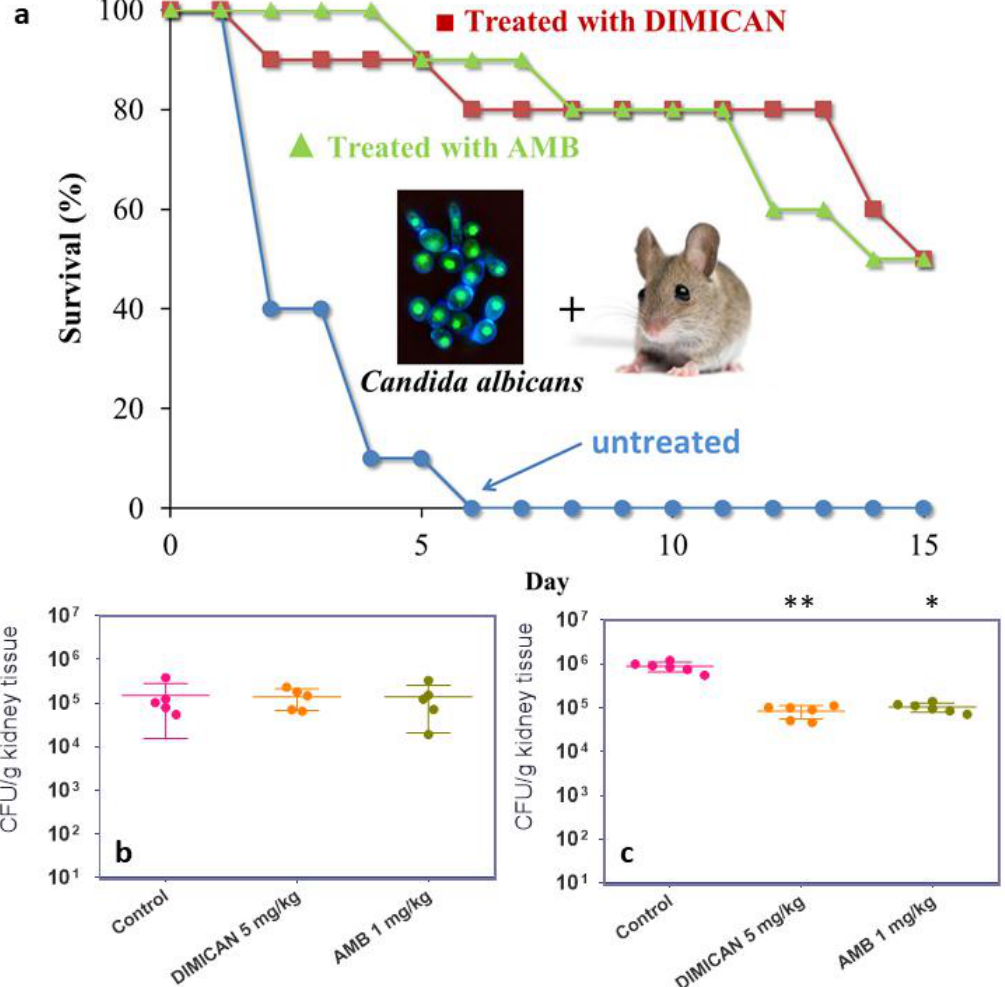
Figure 3. In vivo antifungal activity results for DIMICAN against Candida albicans 3666 isolate. ( a ) Survival curves of mice infected with Candida albicans 3666 isolate. For all groups n = 10. ( b ) Kidney tissue burden of immunosuppressed mice infected by Candida albicans 3666 isolate, two days after infection. ( c ) Six days after infection ( p < 0.05 (*); p <0.001 (**)).